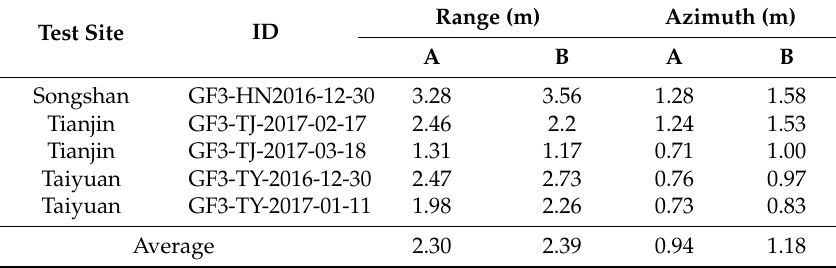
Table 7. Comparison between conventional field calibration (A) and cross-calibration (B)